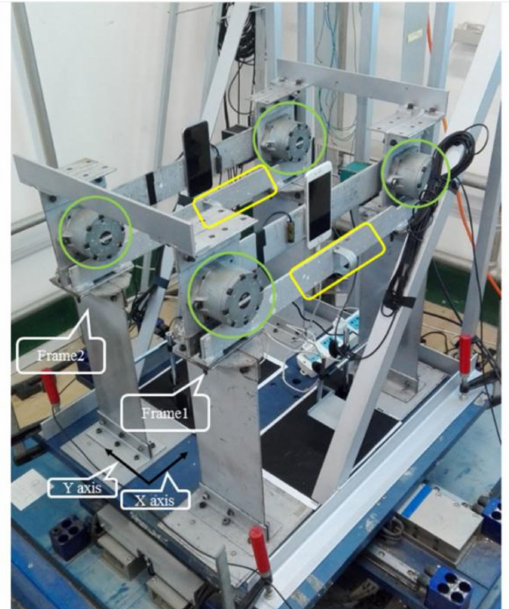
Figure 1. Schematic illustration of the test frame